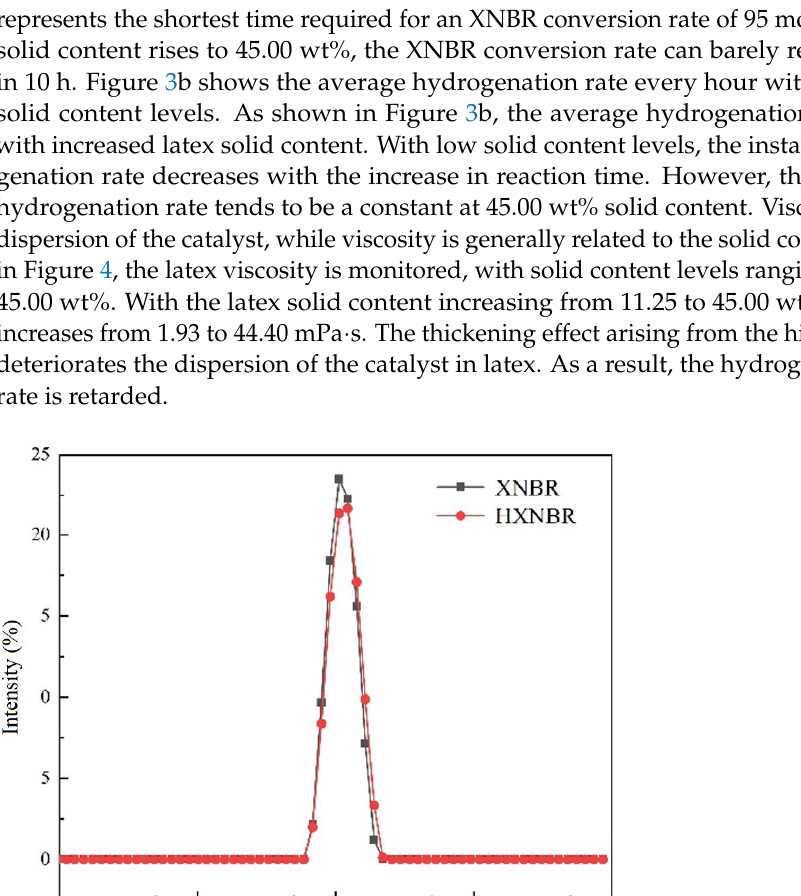
Figure 2. The size distribution of XNBR particles in latex before and after hydrogenation.